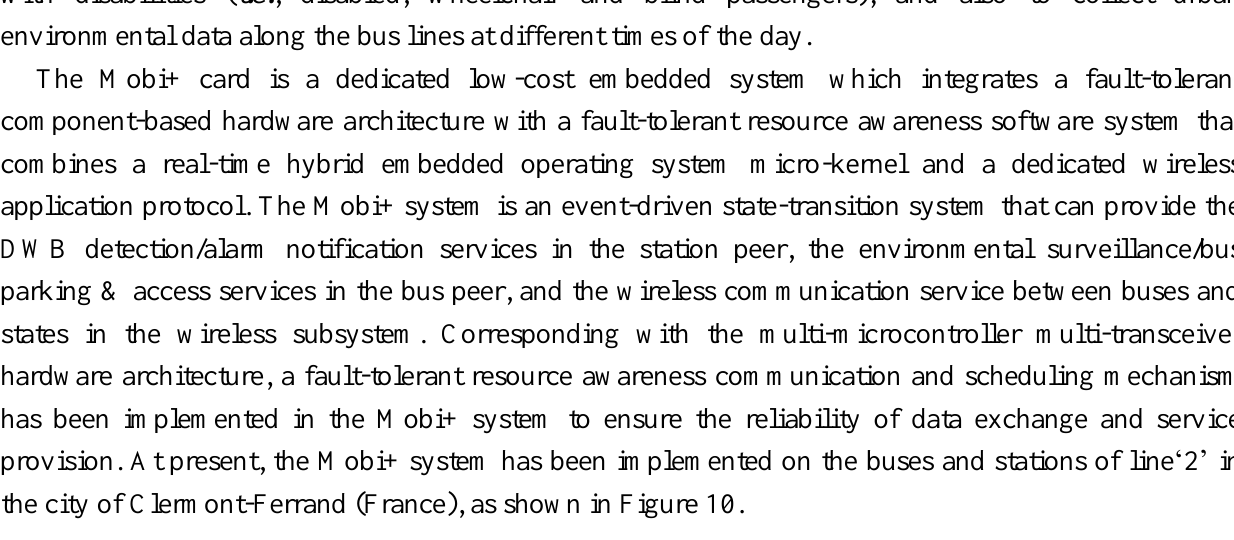
Figure 10. Mobi+ prototype system at Clermont-Ferrand,